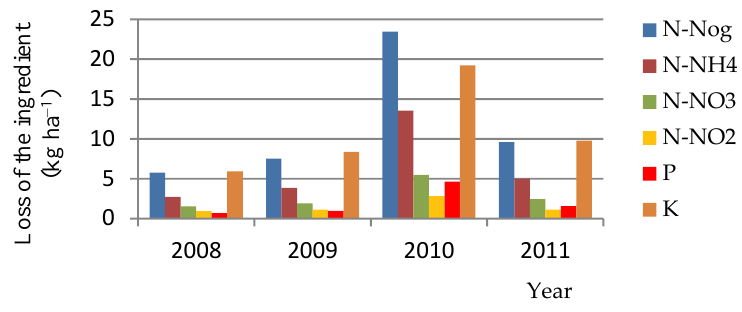
Figure 8. Mass of eroded chemical components (surface runoff).